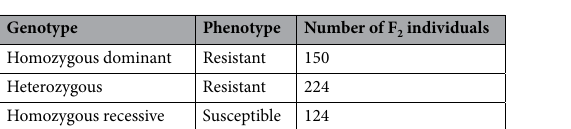
Figure 5. Digested PCR fragments of maker CAPS2430 by restriction enzyme Fau I . ( a ) M: DL2000 DNA Marker, Lane 1: ZQK9, Lane 2: E31, Lane 3: F 1 (E31 × ZQK9), Lane 4–13: 10 resistant F 2 individuals, Lane 14–23: 10 susceptible F 2 individuals. ( b ) M: DL2000 DNA Marker, Lane 1–13: 13 resistant melon accessions, Lane 14–32: 19 susceptible melon accessions.